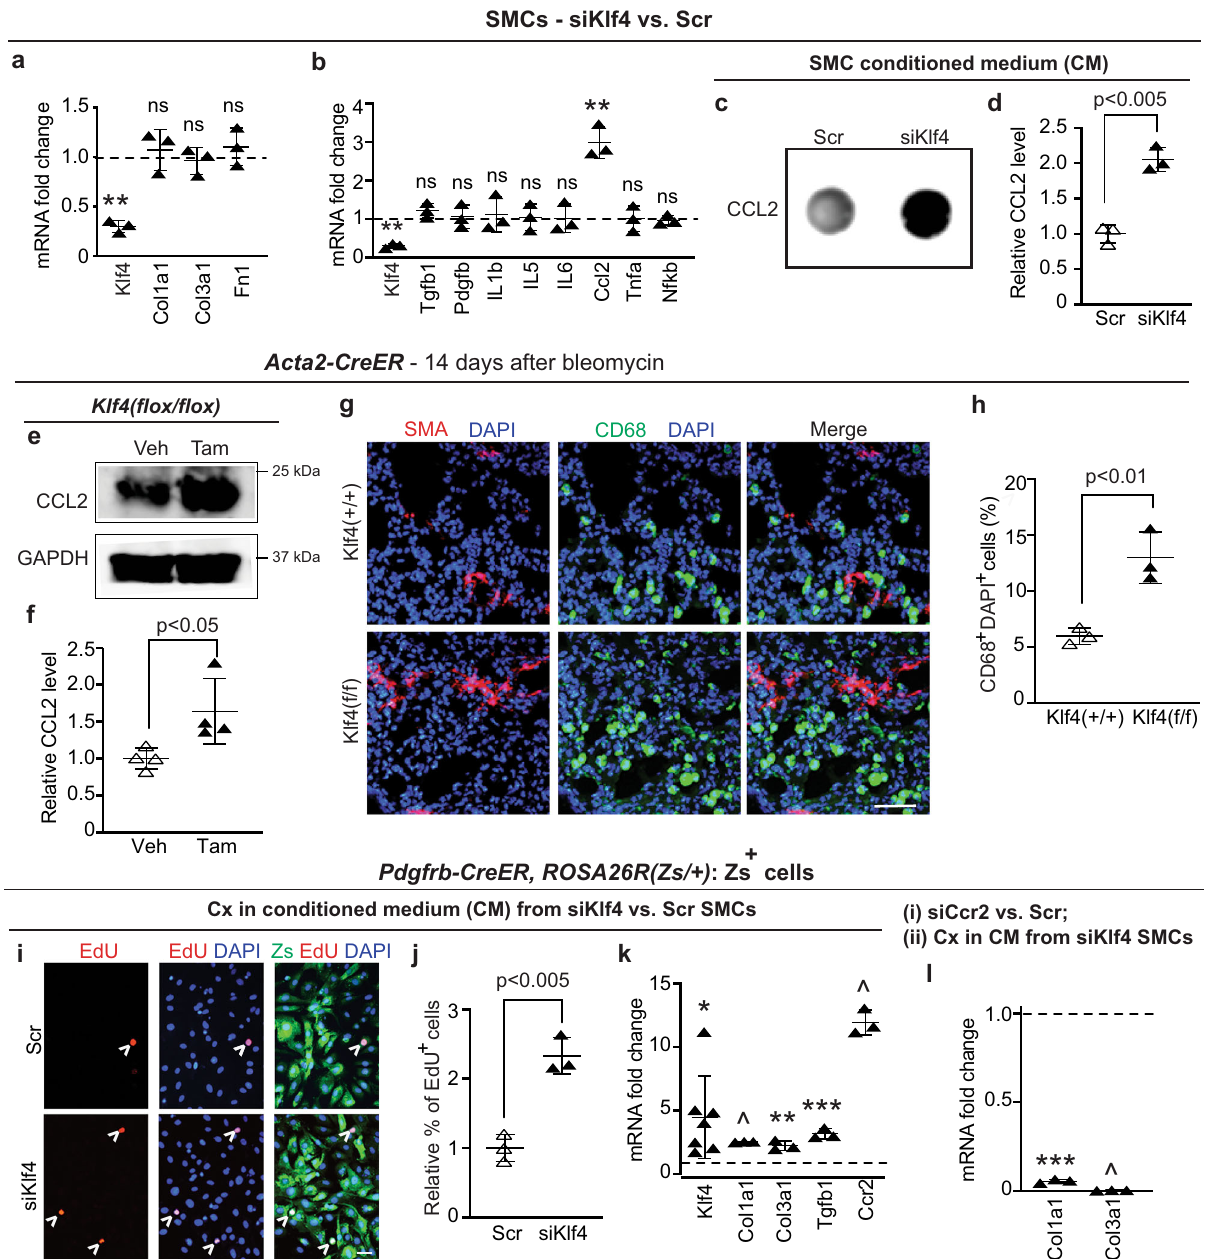
Fig. 6 Reduction of Klf4 in SMA + cells increases Ccl2 levels and noncell autonomously induces Ccr2-mediated collagen expression in PDGFR- β + cells. a – d Klf4 siRNA or scrambled (Scr) RNA treatment of mouse airway SMCs. In a and b , transcript levels were assayed by qRT-PCR. n = 3 in triplicate. **, Klf4 ( p = 0.0035), Ccl2 ( p = 0.0013), ns (not signi fi cant) vs. Scr. Dot blots show CCL2 protein levels in conditioned medium (CM) ( c ) with densitometry normalized to Scr ( d ). n = 3, p = 0.0010. e – h The lungs of Acta2-CreER T2 mice carrying Klf4 ( fl ox/ fl ox) or Klf4 ( + / + ) were analyzed 14 days after a bleomycin dose. In e and f , mice were induced with vehicle (Veh; corn oil) or tamoxifen (Tam) prior to bleomycin, and lung lysates were subjected to western for CCL2 and GAPDH with densitometry relative to GAPDH and normalized to vehicle. n = 4, p = 0.033. In g and h , mice were induced with tamoxifen prior to bleomycin, and lung sections were stained for SMA and macrophage marker CD68. Percent of DAPI + cells that express CD68 was quanti fi ed ( h ). n = 3 mice, fi ve sections per mice and an average of 906 DAPI + cells per section, p = 0.0073. i – l Pdgfrb-CreER T2 , ROSA26R (Zs/ + ) mice were induced with tamoxifen, and Zs + cells were isolated by FACS. In i – k , Zs + cells were cultured (cx) in CM from airway SMCs pretreated with siKlf4 or Scr RNA. In i , cells were cultured with EdU for 8 h prior to staining for EdU and nuclei (DAPI) and direct Zs imaging. The percent of DAPI + cells that were EdU + (arrowheads) was quanti fi ed and normalized to percentage for Scr CM-treated cells ( j ). n = 3 experiments, fi ve microscopic fi elds of view per experiment and on average 279 DAPI + cells per fi eld, p = 0.0022. In k , transcript levels relative to Gapdh were measured by qRT-PCR and normalized to Scr CM-treated cells. n = 7 for Klf4 and n = 3 for other transcripts. * p = 0.016; ** p < 0.0043; *** p = 0.0008; ^, <0.0001 vs. Scr. In l , Zs + cells were subjected to siCcr2 vs. Scr and then cultured in medium preconditioned by siKlf4-treated SMCs. qRT-PCR was used to measure Col1a1 and Col3a1 mRNA levels. n = 3, *** p = 0.0008, ^ p < 0.0001 vs. Scr. Two-tailed Student ’ s t test was used for all analysis. Data are averages± SD. Source data are provided as a Source Data fi le. Scale bars, 50 μ